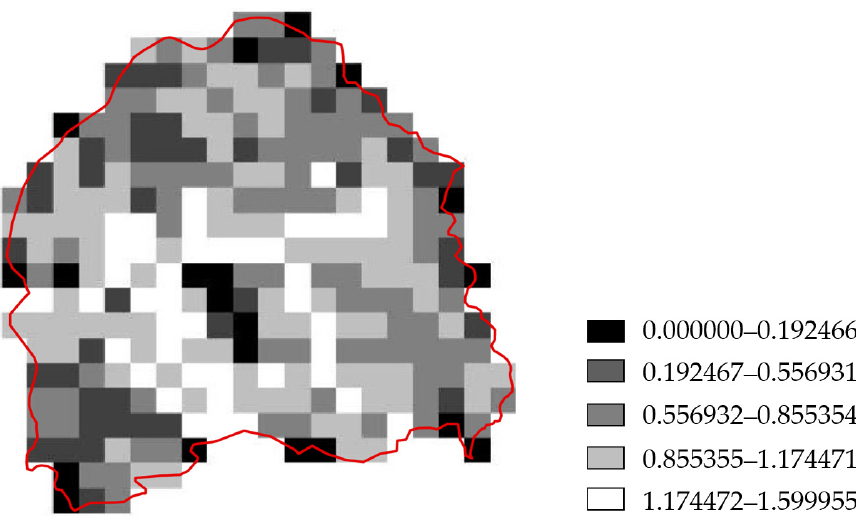
Figure 3. The SHDI distribution value within the grid.